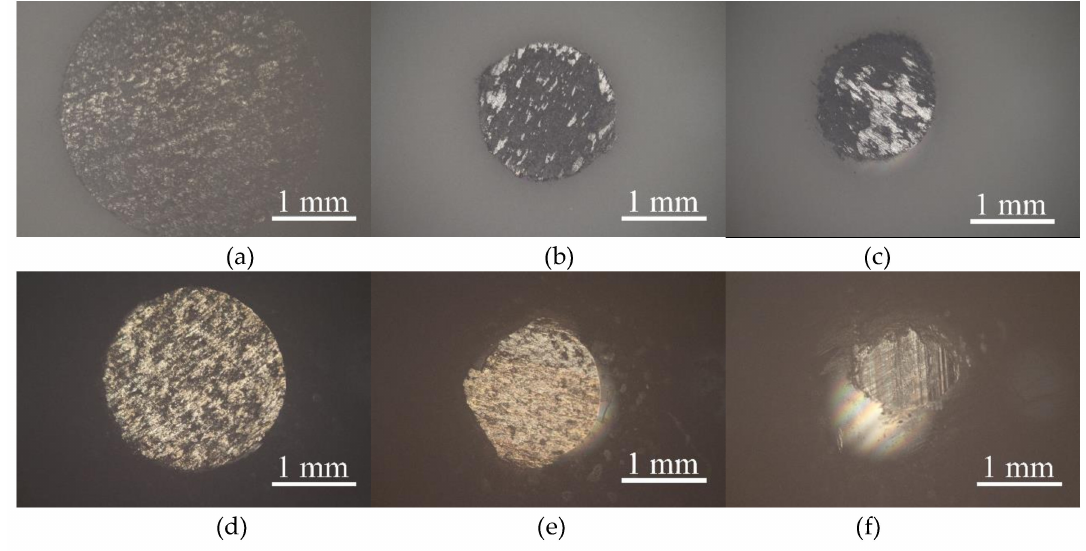
Figure 5. The worn surfaces of the alloy against Al 2 O 3 and Si 3 N 4 at different testing temperatures. ( a ) Al 2 O 3 -200 ◦ C; ( b ) Al 2 O 3 -400 ◦ C; ( c ) Al 2 O 3 -750 ◦ C; ( d ) Si 3 N 4 -200 ◦ C; ( e ) Si 3 N 4 -400 ◦ C; ( e ) Si 3 N 4 -750 ◦